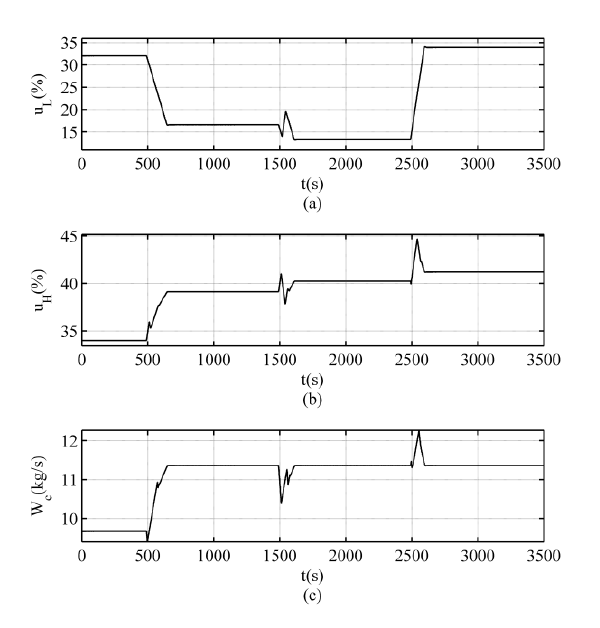
Fig.3 Curve for control